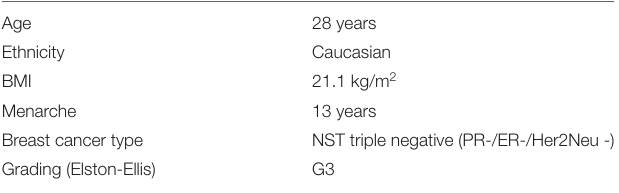
TABLE 1 | Patient’s clinical